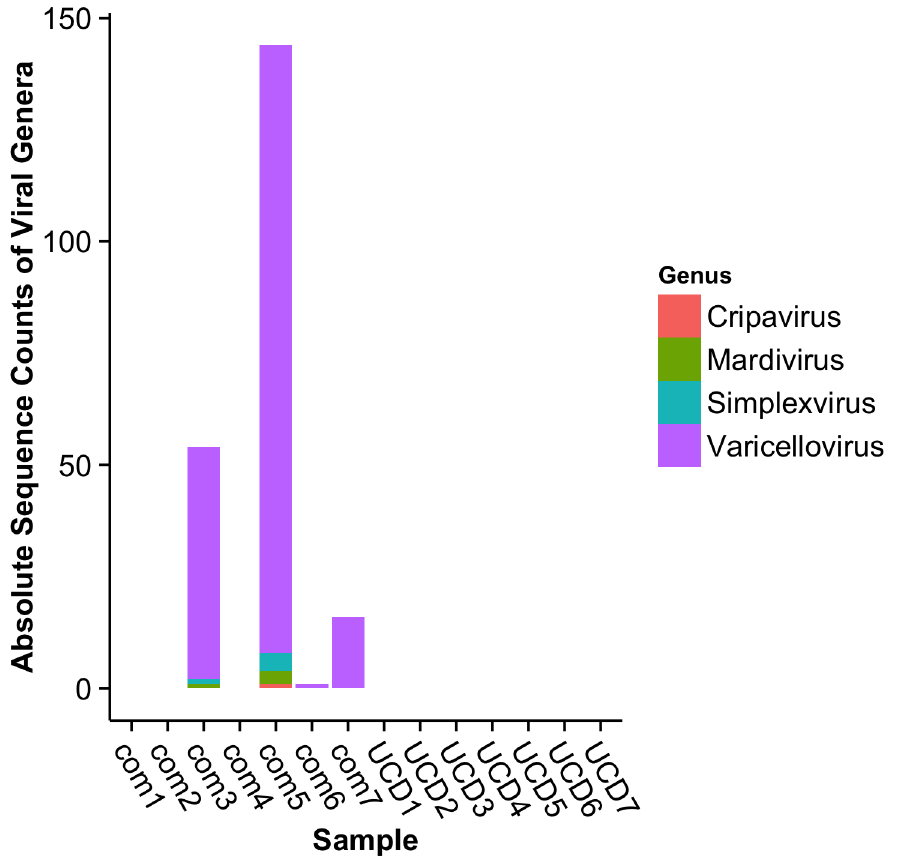
Fig 1. Viral genera associated with stranded harbor seal brain tissues. Absolute sequence counts of assignments to viral genera from comparative (com) and unknown cause of death (UCD) harbor